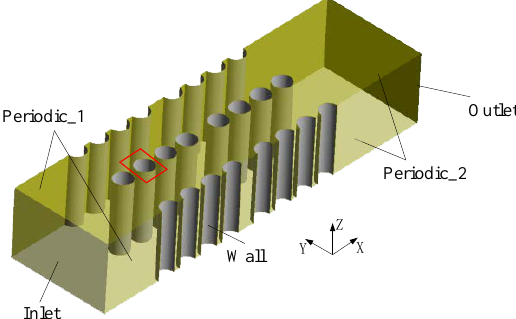
Figure 5. Three-dimensional diagram of the economizer unit.